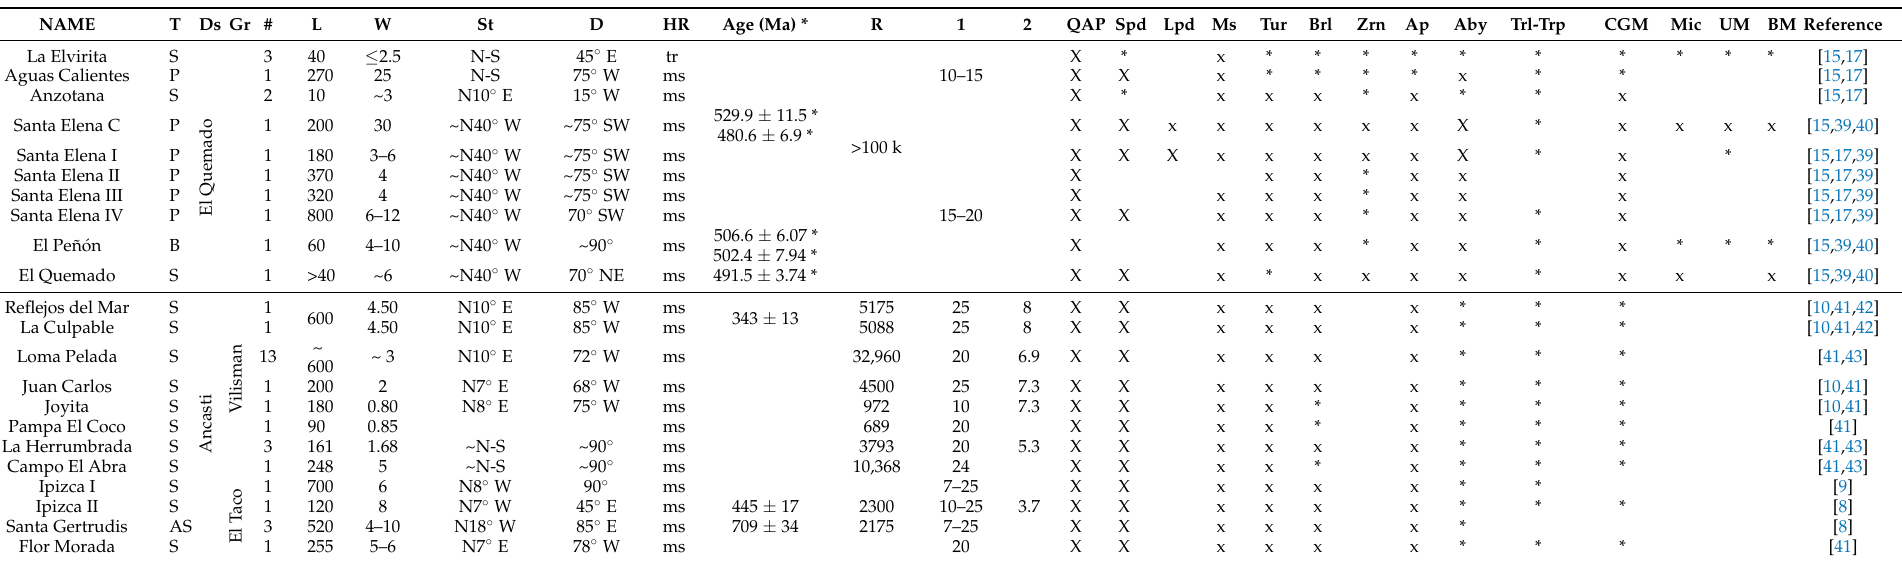
Table 1. Main parameters and mineralogy of lithium pegmatites from the El Quemado and Ancasti